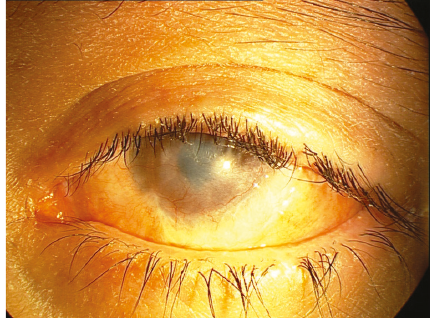
Figure 2: Photo-slit lamp image demonstrating rapid remission of the lesion after treatment with IV acyclovir in the patient’s left